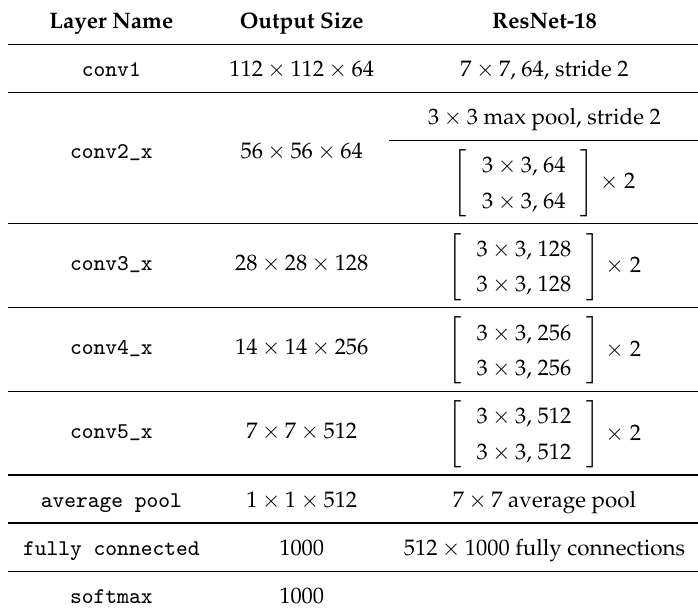
Table 1. ResNet-18